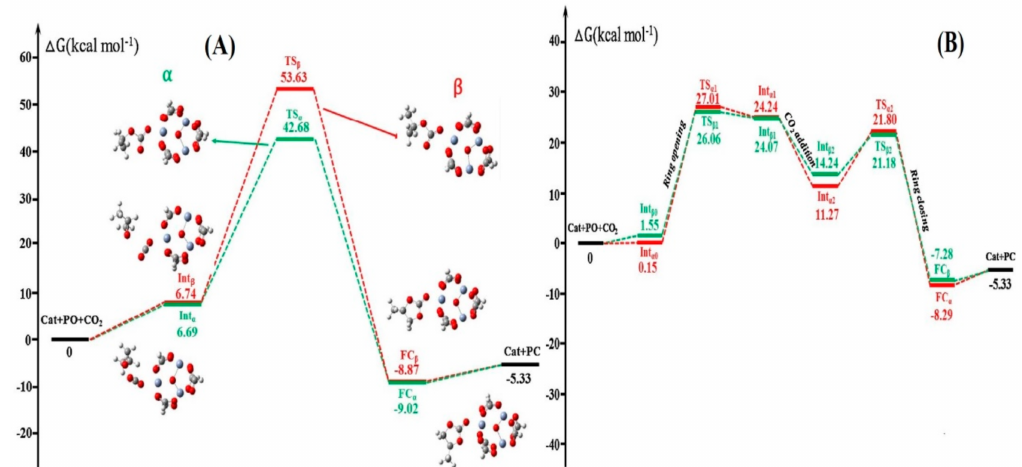
Figure 16. Gibbs free energy surface profile of ( A ) MIL-101-catalyzed reaction ( B ) TBABr-catalyzed reaction, with optimized geometries of intermediates and transition states. Reproduced with permission Ref. [67]. Copyright 2018 Elsevier.